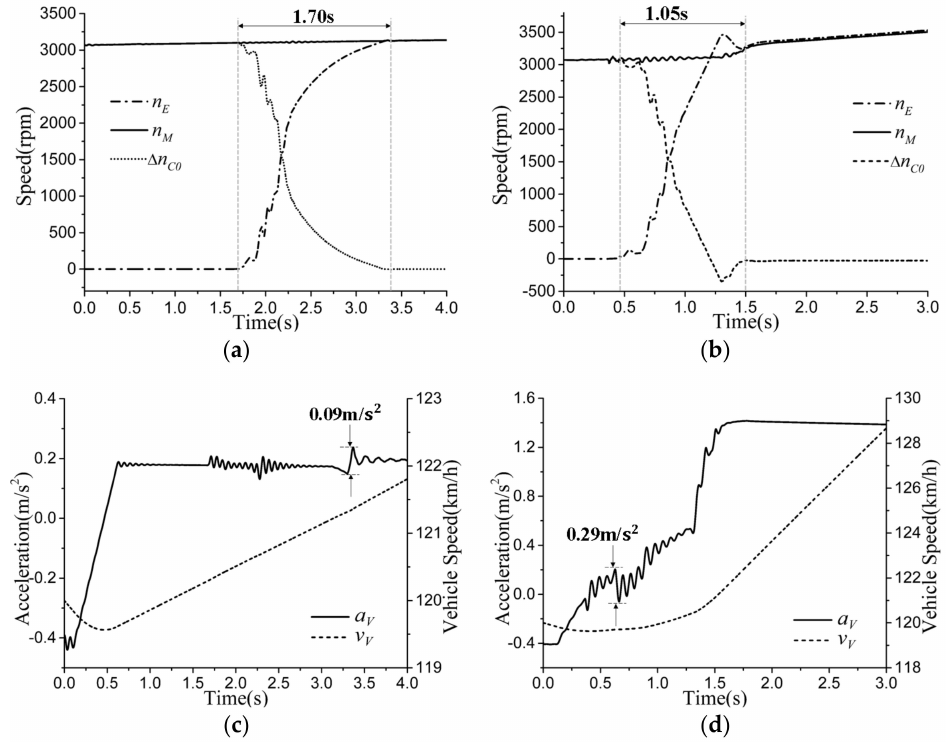
Figure 16. Comparative simulation results of two transitions in the high-speed driving condition: soft start: ( a , c ); dynamical start: ( b , d